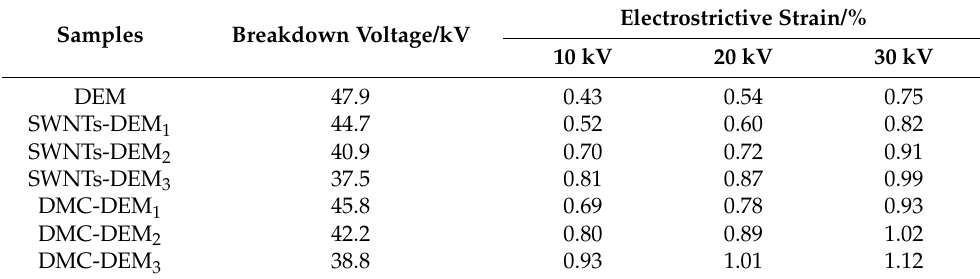
Table 7. Electrostrain data of a series of polyurethane composite membranes. Samples Breakdown